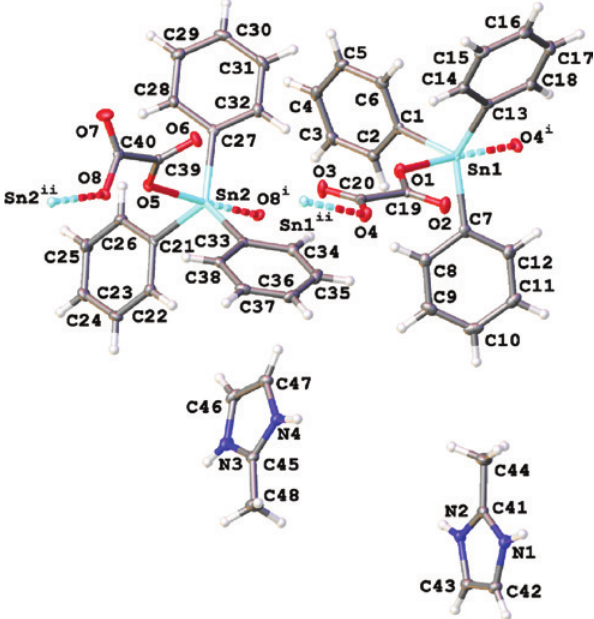
Figure 1: Molecular structure of 1 (asymmetric unit) showing 50% probability ellipsoids and the crystallographic numbering scheme (Ortep